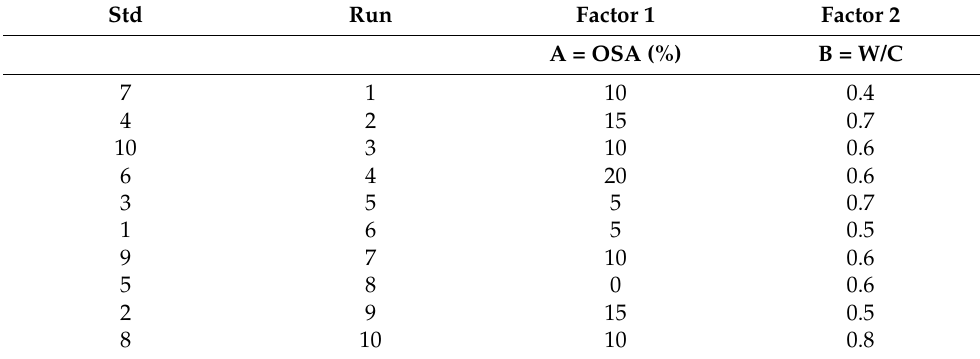
Table 2. Mix formulations of